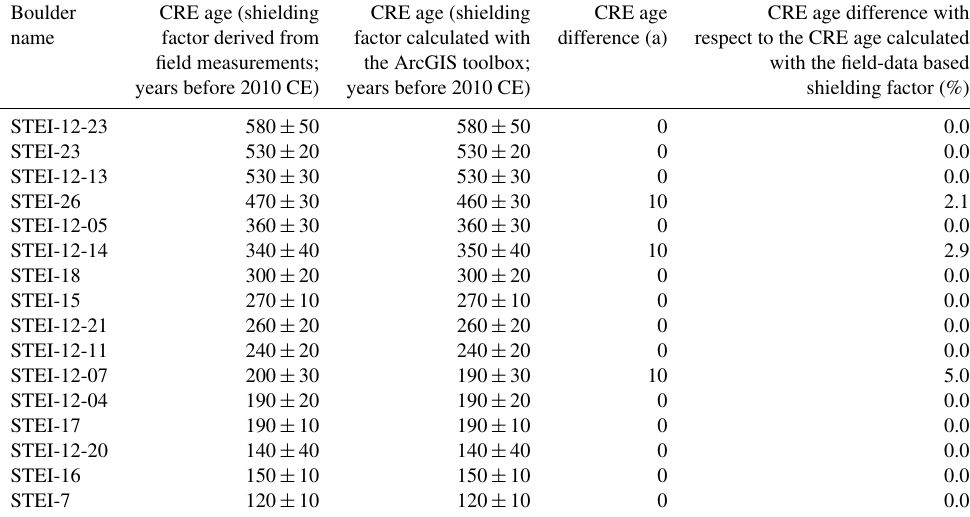
Table B3. Recalculated CRE ages of moraine boulders in the forefield of Steingletscher (Switzerland; Schimmelpfennig et al., 2014). In the CREp (Martin et al., 2017), CRE ages were first calculated with topographic shielding factors derived from field measurements (presented in Schimmelpfennig et al., 2014) and then with topographic shielding factors calculated with the ArcGIS-toolbox of Li (2018) and SRTM elevation data (NASA Jet Propulsion Laboratory,